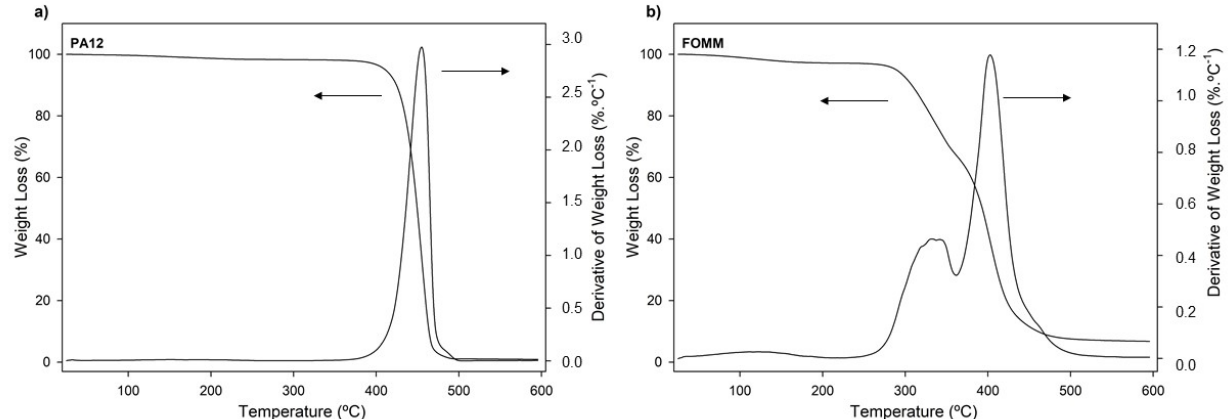
Figure 4. Weight loss and derivative of weight loss (DTG) thermogravimetric curves of ( a ) PA12 and ( b ) FOMM, as received.